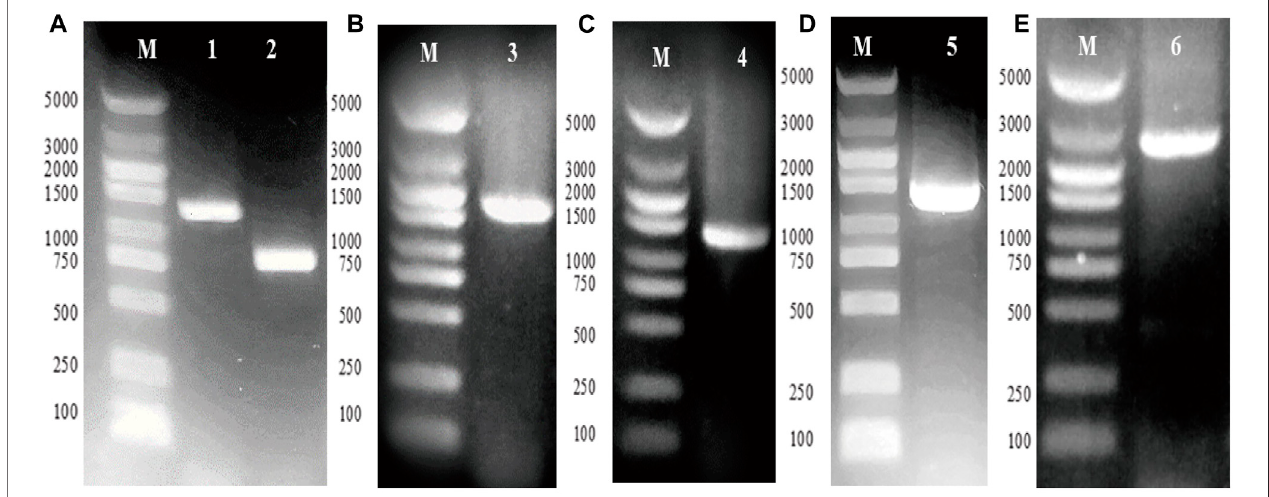
FIGURE 2 | Construction of plasmid ptac-G12 that co-expressing gpd1 and gpp2 under tac promoter. G1 denotes gpd1 gene encoding glycerol 3-phosphate dehydrogenase; G2 denotes gpp2 gene encoding glycerol 3-phosphatase; and G12 denotes co-expression of gpd1 and gpp2 . (A) PCR ampli fi cation of the gpd1 and gpp2 genes from S. cerevisiae . (B) Colony PCR ofplasmid ptac- gpd1 . (C) Colony PCRof plasmid ptac- gpp2 . (D) PCR ampli fi cation of ptac- gpd1 expression cassette. (E) Colony PCR of gpd1 and gpp2. M, Marker; lane 1, gpd1 gene; lane 2, gpp2 gene; lane 3, plasmid ptac- gpd1 expression cassette; lane 4, plasmid ptac- gpp2 expression cassette; lane 5, plasmid ptac- gpd1 expression cassette; and lane 6, colony PCR of the co-expressed gpd1 and gpp2 in